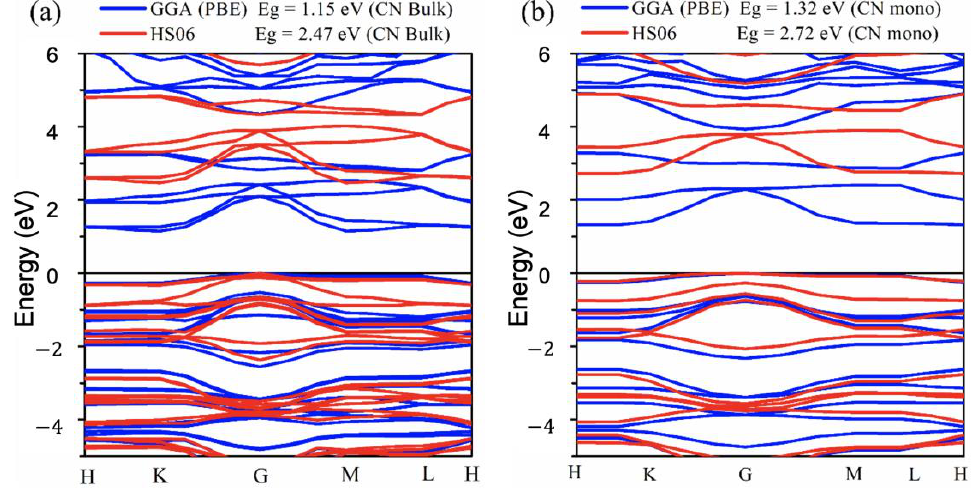
Figure 8. Band structure of gCN bulk ( a ) and gCN monolayer ( b ) obtained by DFT calculations using GGA-PBE (blue) and HS06 (red) approximations.